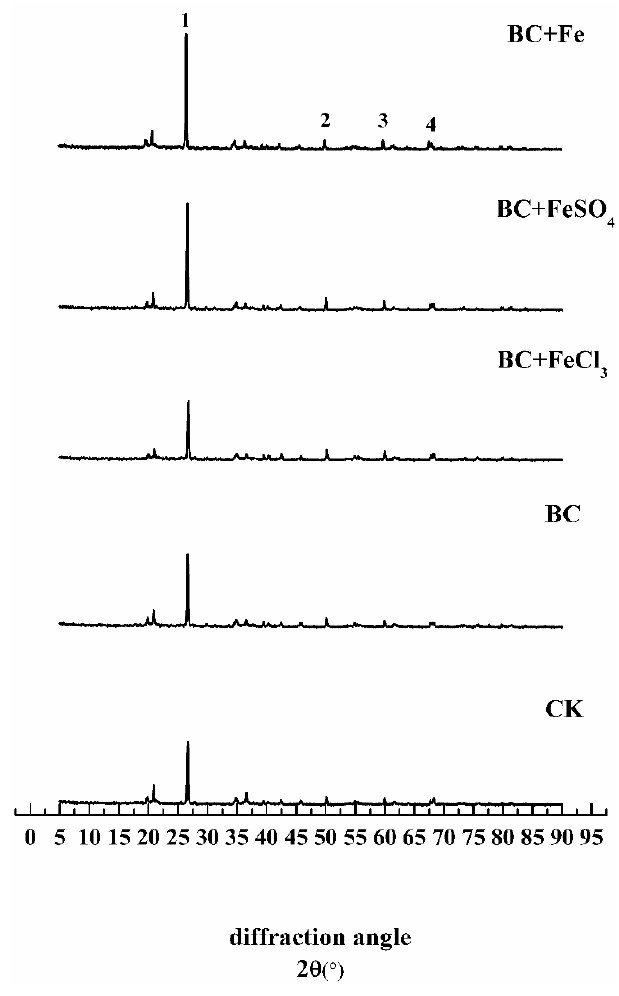
Figure 5. X-ray diffraction (XRD) patterns of the soil under different treatments. 1: Pb 5 O 4 , 2: Cd(OH)NO 3 , 3: Pb 3 (CO 3 ) 2 (OH) 2 , 4: Cd(OH) 2 , BC: biochar, CK: control.